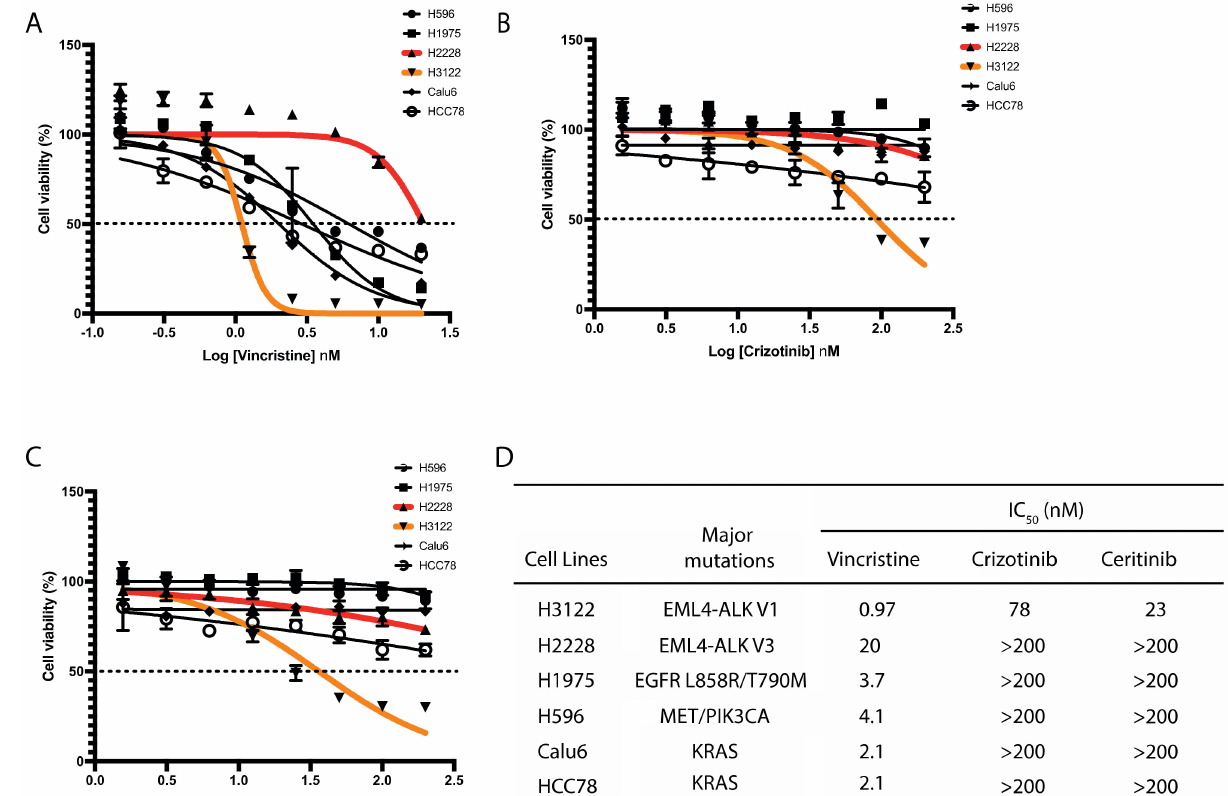
Figure 1. H3122 but not H2228 cells are sensitive to vincristine and ALK-TKIs. ( A – C ). Lung cancer cells were treated with increasing doses of vincristine ( A ), crizotinib ( B ) and ceritinib ( C ) for 72 h. Cell viability was determined using CellTiter-Glo assays. The IC 50 values were calculated using the Prism 9.0 software. Data represent the mean of three biological replicates in each column; the bars denote ± SD. ( D ). Table summarises the IC 50 of vincristine and ALK inhibitors in lung cancer cell lines harbouring major oncogenic